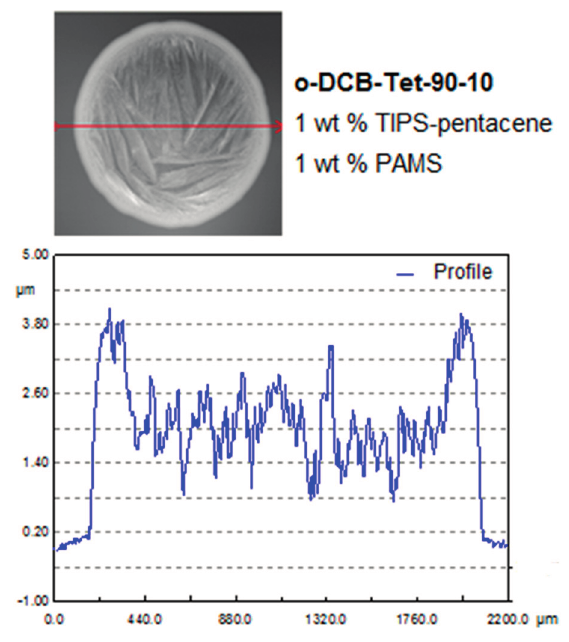
Figure 6. Profilometry results of the D1_PAMS drop. It can be seen that the surface still exhibits discontinuities at the crystal